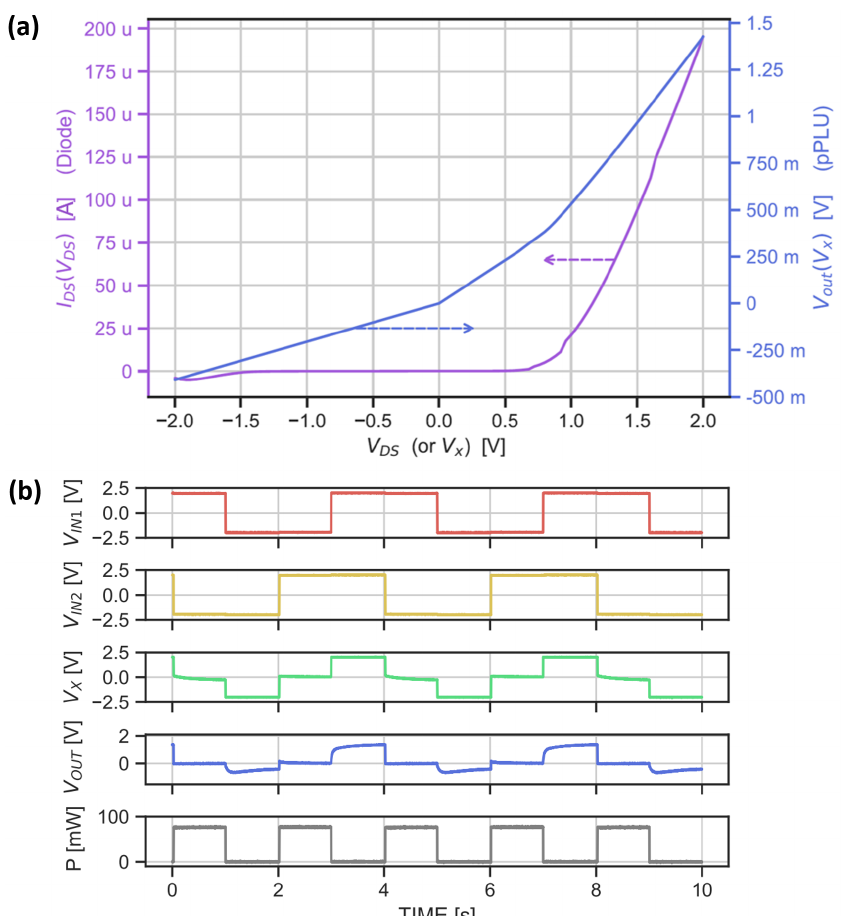
Figure 7. ( a ) DC measurement of EGT-based diode ( I DS ( V DS ) ) and activation function ( V out ( V x ) ). ( b ) Transient measurements of the printed